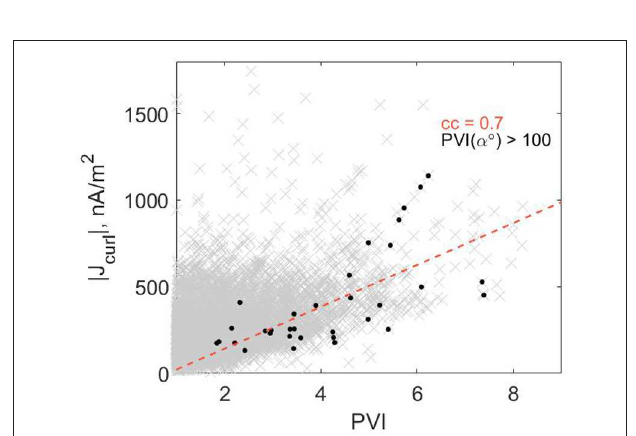
et al., 2016; Yordanova et al., 2016) can correspond to potentially reconnecting current